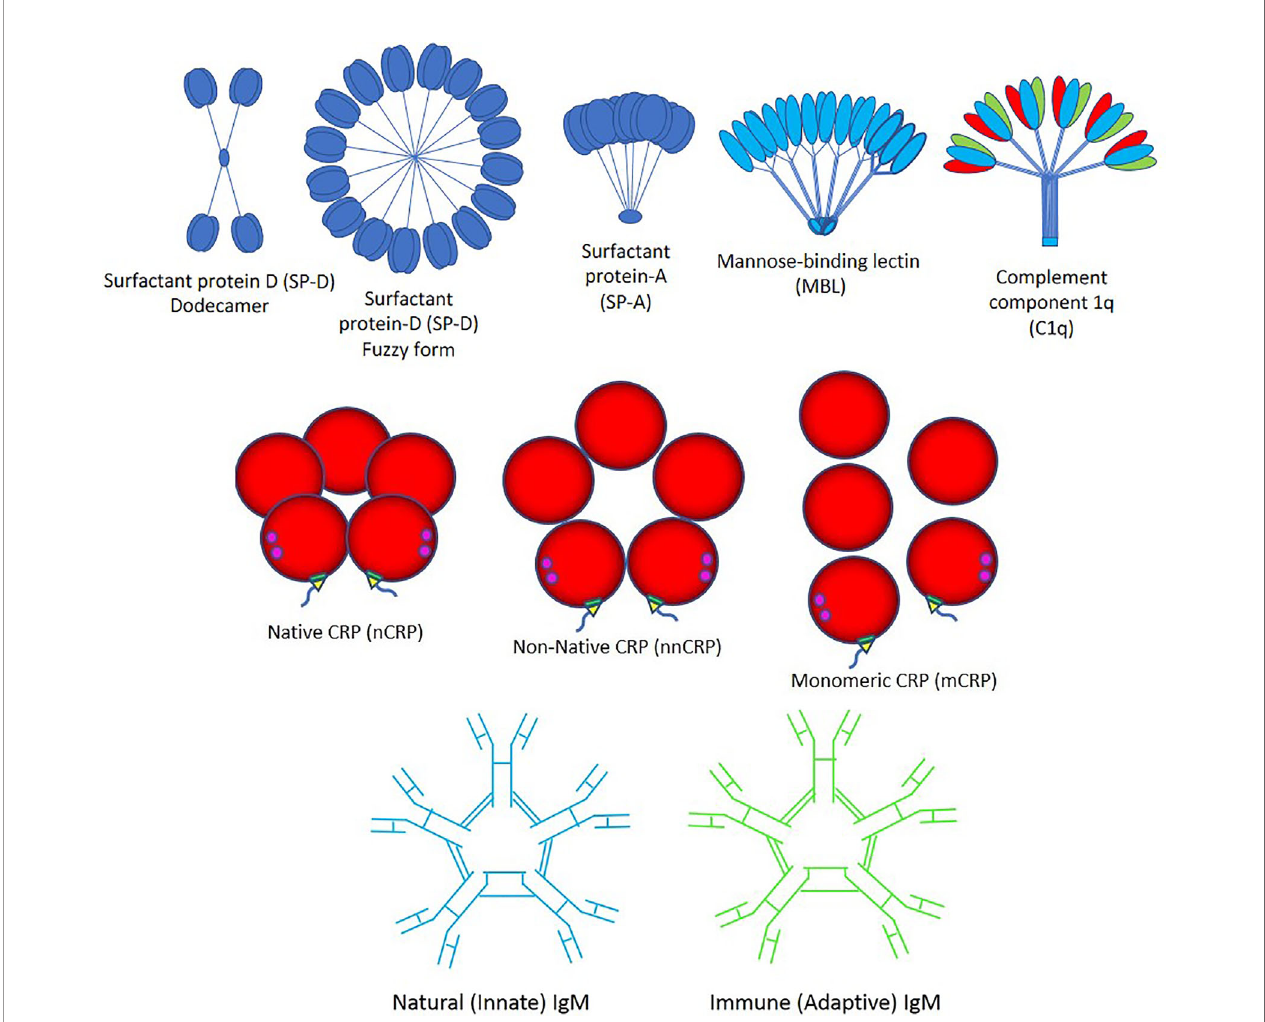
FIGURE 2 | Pattern recognition proteins. The trident of pattern recognition proteins is composed by: (Top) surfactant proteins D and A (SP-D and -A), mannose- binding lectin (MBL) and complement component 1q (C1q); (Middle) native C-reactive protein (nCRP), non-native CRP (nnCRP) and monomeric CRP (mCRP); and (Bottom) natural (innate) immunoglobulin M (IgM) and immune (adaptive)